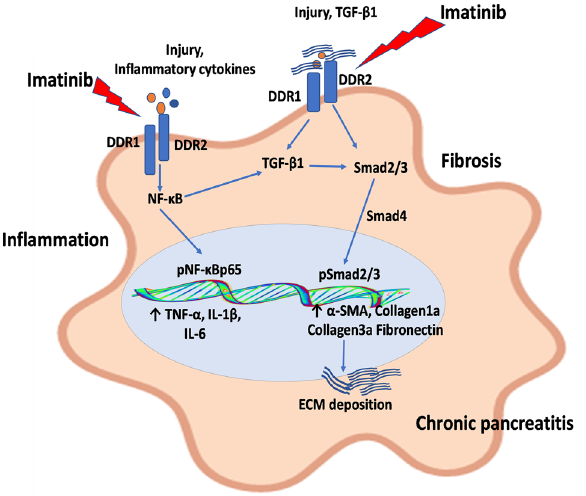
Figure 8. Schematic diagram of the molecular mechanisms of discoidin domain receptors (DDR1/DDR2) in the activation of pancreatic stellate cells (PSCs) and progression of pancreatic fibrosis. During